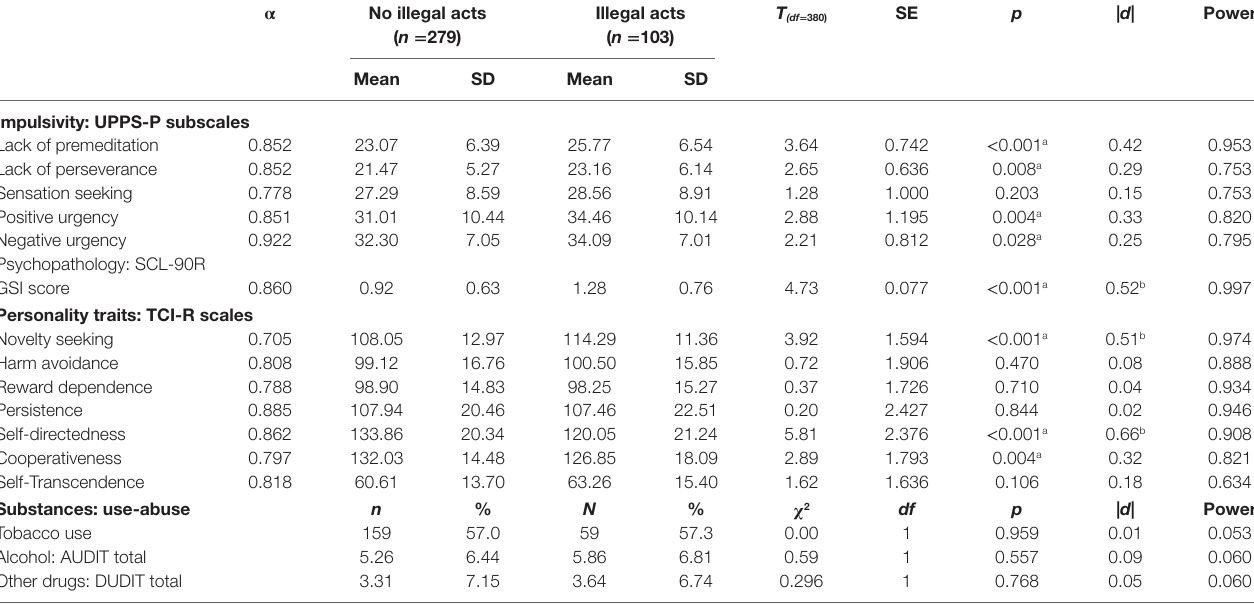
TaBle 2 | Clinical comparison between patients with and without illegal acts. α no illegal acts ( n =